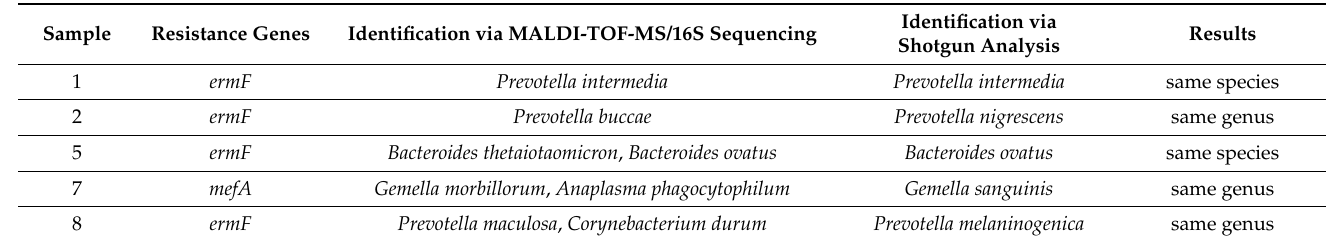
Table 7. Comparison of the different methods used for